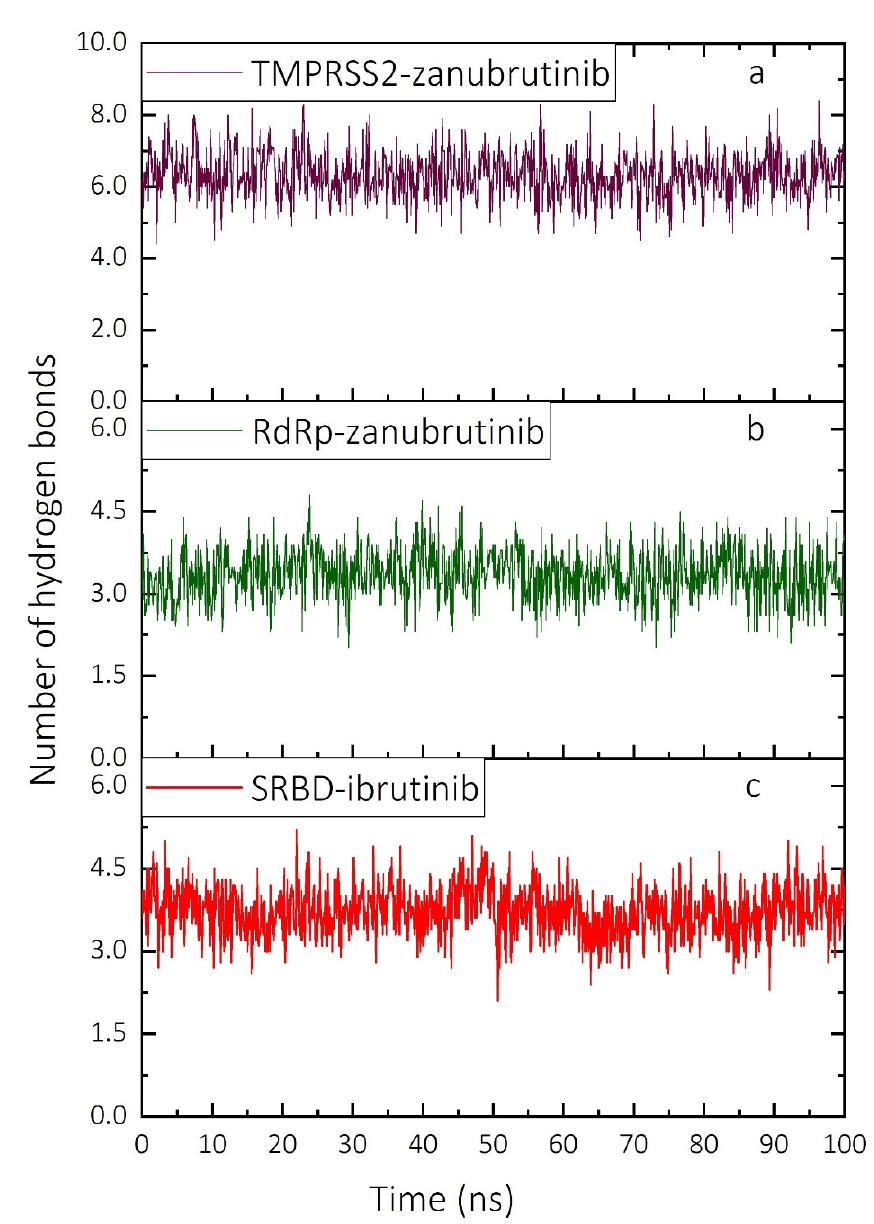
Figure 6. Number of intermolecular HB interactions in the complexes of targets (SRBD, RdRp and TMPRSS2) and ligands (ibrutinib and zanubrutinib) over the 100-ns timescale of MD simulations performed with NAMD. ( a ) TMPRSS2–zanubrutinib complex, ( b ) RdRp–zanubrutinib complex and ( c ) SRBD–ibrutinib complex. SRBD—spike protein receptor-binding domain; RdRp—RNA-dependent RNA polymerase; TMPRSS2—transmembrane serine protease 2; HB—hydrogen bond.